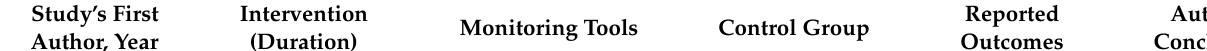
Table 3. The intervention, control, reported outcomes and authors conclusion of the six included